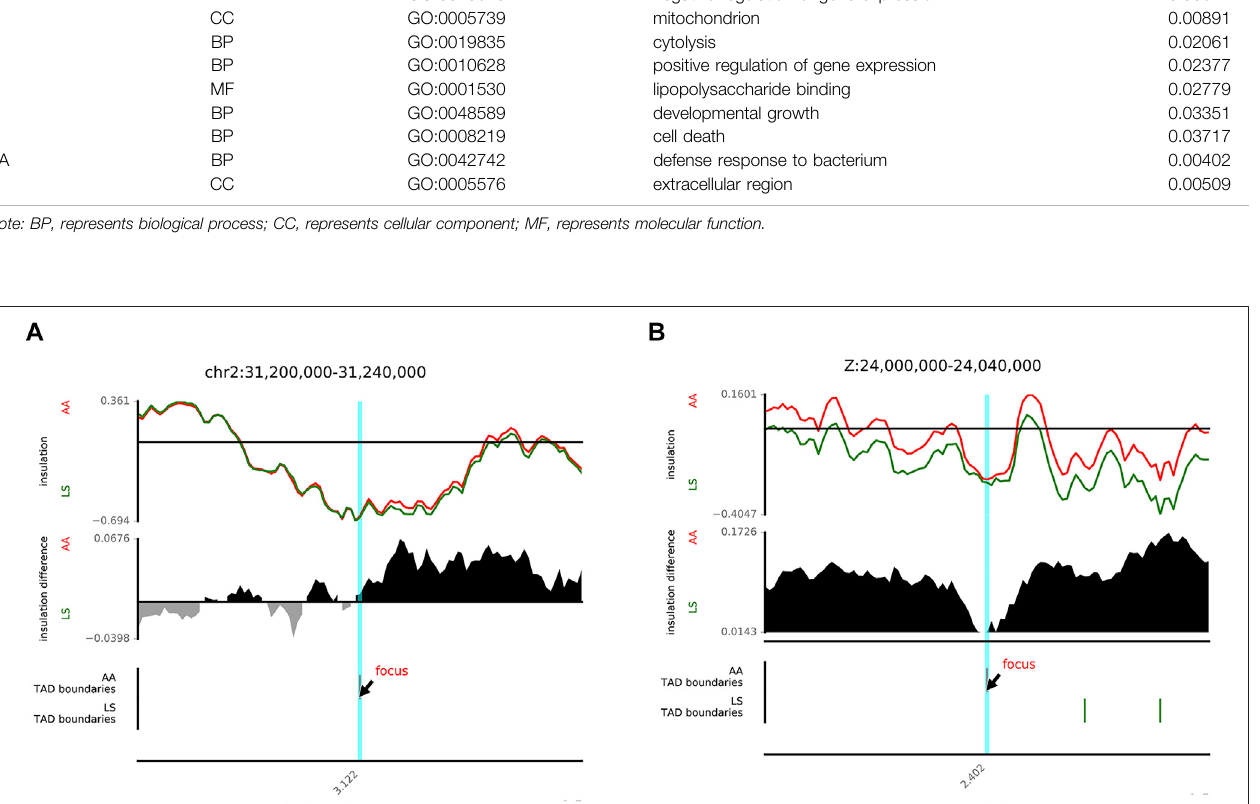
Frontiers in Cell and Developmental Biology |